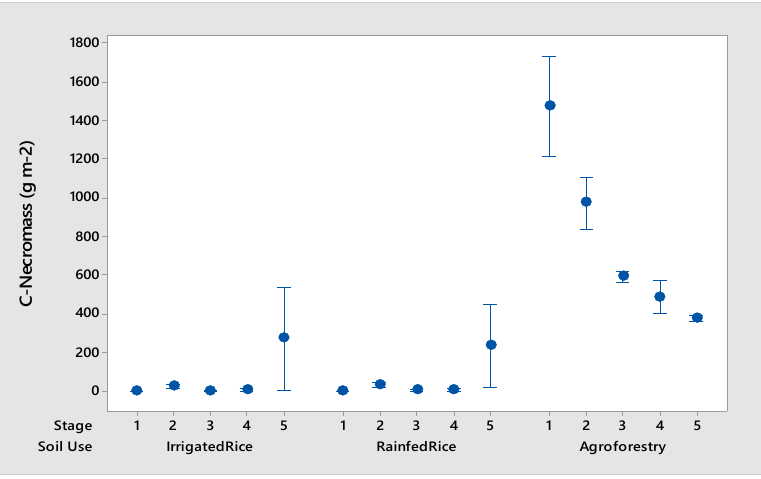
Figure 5. Effect of the soil use and stage on the carbon of the necromass ( n = 6).